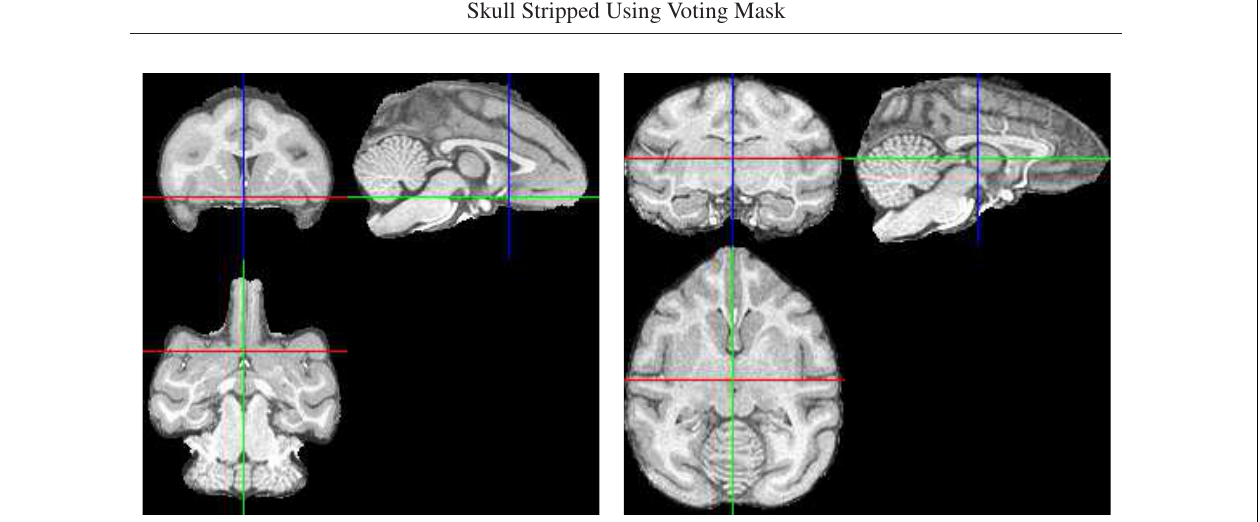
remaining and one with brain areas (anterior and posterior) removed. Bottom row : both problems are largely fixed using the voting bootstrap procedure described in the